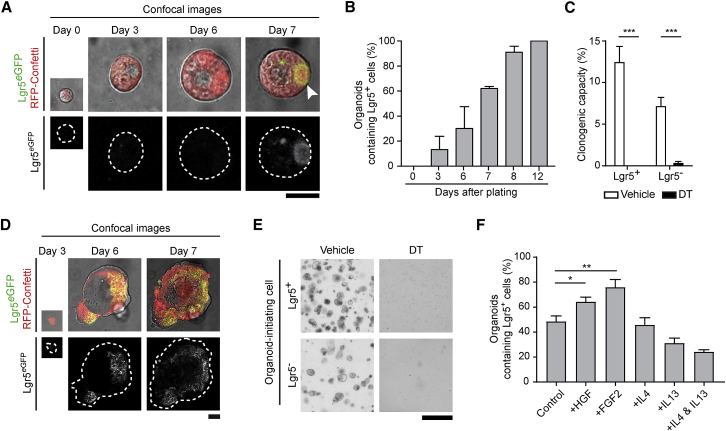
Disseminating Lgr5− Cancer Cells Undergo Niche-Independent Cellular Plasticity(A) Representative example of organoid formation assay of sorted Lgr5− circulating cancer cells. Dashed lines highlight organoids edges. Arrowhead indicates the appearance of a Lgr5+ CSC. Scale bar, 20 μm.(B) Quantification of cancer cell plasticity (i.e., emergence of Lgr5+ CSCs) in the organoid-forming assay of sorted Lgr5− circulating cancer cells grown in minimal CRC medium. Data are presented as mean ± SEM (n = 3 independent experiments).(C) Clonogenicity assay in minimal CRC medium of sorted Lgr5+ CSCs and Lgr5− cancer cells derived from CRC organoid cultures. Single cells were subjected to either vehicle or diphtheria toxin (DT) treatment (n = 3 independent experiments). Data were collected 6 days after plating. Values are presented as mean ± SEM; ∗∗∗p < 0.0001, calculated using the unpaired t test with Welch’s correction.(D) Representative example of organoid formation assay of sorted Lgr5− cancer cells cultured in synthetic hydrogel. Dashed lines highlight organoids edges. Scale bar, 50 μm.(E) Representative images of the effect of vehicle or diphtheria toxin (DT) on sorted Lgr5+ CSCs and Lgr5− cancer cells cultured in synthetic hydrogel 6 days after plating (n = 3 independent experiments). Scale bar, 200 μm.(F) Quantification of cancer cell plasticity (i.e., emergence of Lgr5+ CSCs) of sorted Lgr5− cancer cells grown in either minimal CRC medium (control) or medium containing FGF-2 (10 ng/mL), HGF (75 ng/mL), IL4 (20 ng/mL), IL13 (100 ng/mL), and IL4 and IL13. n = 3 independent experiments. ∗p < 0.05 and ∗∗p < 0.001, calculated using the unpaired t test. Data are represented as mean ± SEM.